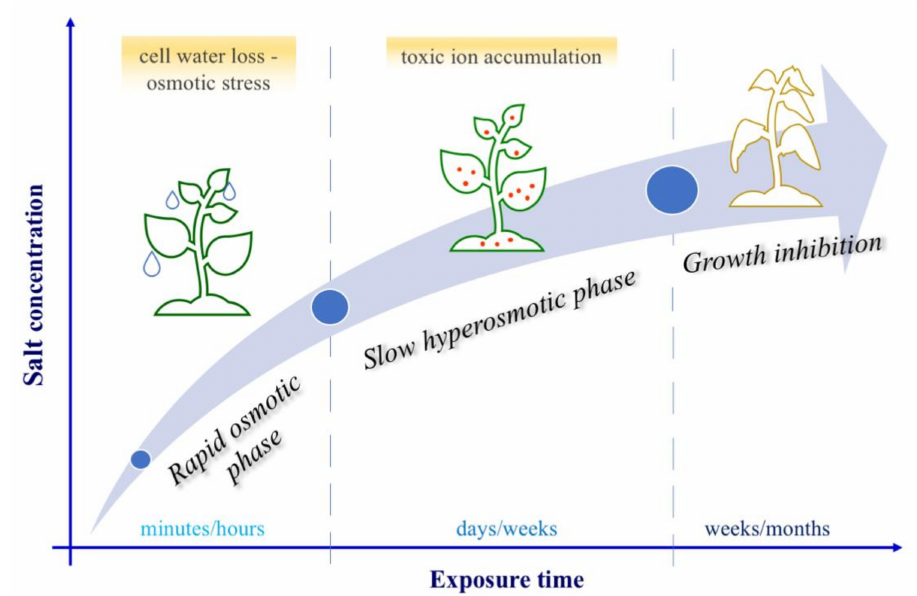
Figure 3. Plant responses to salt stress. Plants cope with the increase in salt concentration in di ff erent ways as the time of exposure to stress increases. Three phases are identified: a faster first reaction (minutes / hours) called rapid osmotic phase; one in the order of days / weeks called slow hyperosmotic phase; and a long term exposure (weeks / months) which leads to inhibition of growth and cell